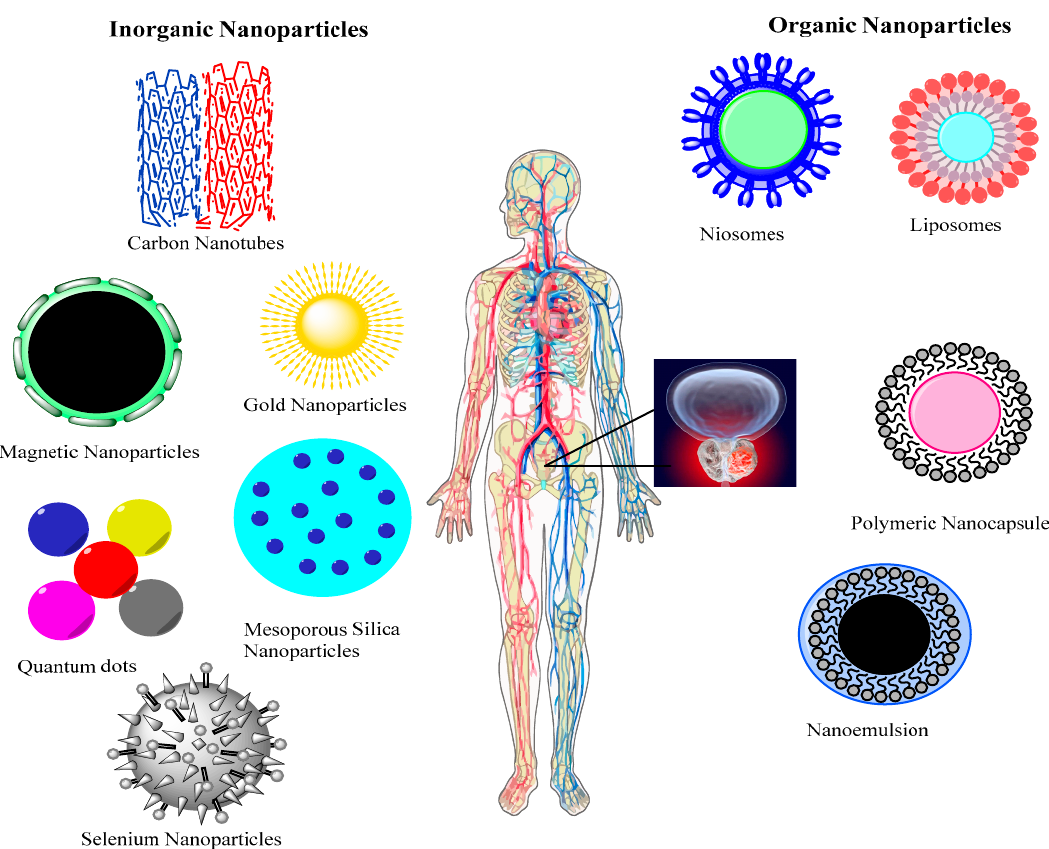
Figure 1. Applications of inorganic and organic nanomaterials in treatment of prostate cancer. Reproduced from [79] with permission from DeGruyter, 2017.